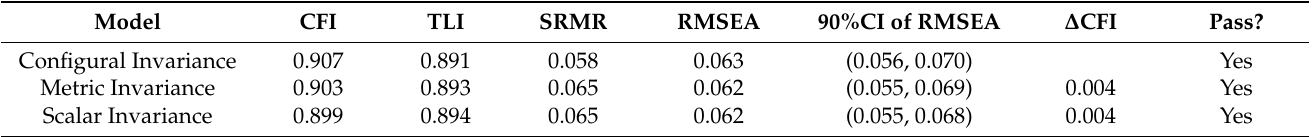
Table 7. Measurement invariance of PANAS.